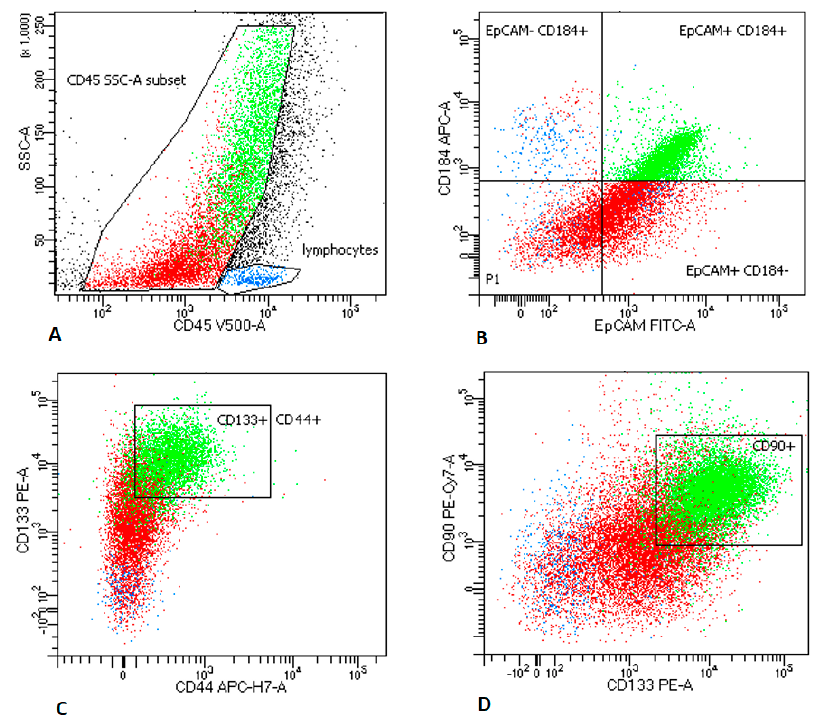
Figure A2. The gating strategy of cancer cells and CSCs in LNs aspirates. ( A ) The population of CD45- cells (nonlymphoid origin). ( B ) CD45-/CXCR4+/EpCAM+ gate; mature tumor cells (MTCs). ( C ) Among cancer cells, 32.5% cells express markers of stemness (CD44 and CD133). ( D ) Among CD45- /CD184+/CXCR4+/CD44+/CD133+ cells 35% of cells express additional marker of stemness CD90. CSCs represent 12.5% of all cells in LN aspirate.